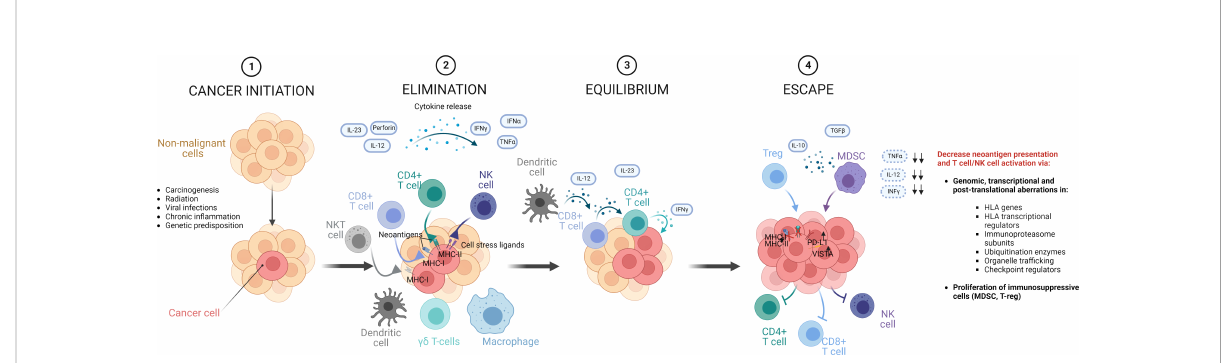
FIGURE 4 Phases of cancer immunoediting. In the natural history of a tumor, aberrant cells that fail intrinsic mechanisms of control and tumor suppression, are exposed to an external control operated by innate and adaptive immunities, which initially contain cancer progression, contributing to sculpt its genomics, by eliminating cells with higher immunogenic potential. This immunological mechanism starts a process called immunoediting, in which cancer cells are exposed to T-cell and NK selective pressures. This phase of elimination is in general followed by an equilibrium phase, where all the mechanisms of tumor-surveillance are operative and constrain tumor cells, reaching a balance. In this context, rare cells can develop immune resistance, ultimately reducing the presentation of immunogenic neoantigens and T cell activation and entering into an escape phase in which tumor progression takes over, because not restricted anymore by the immune system. Figure created with